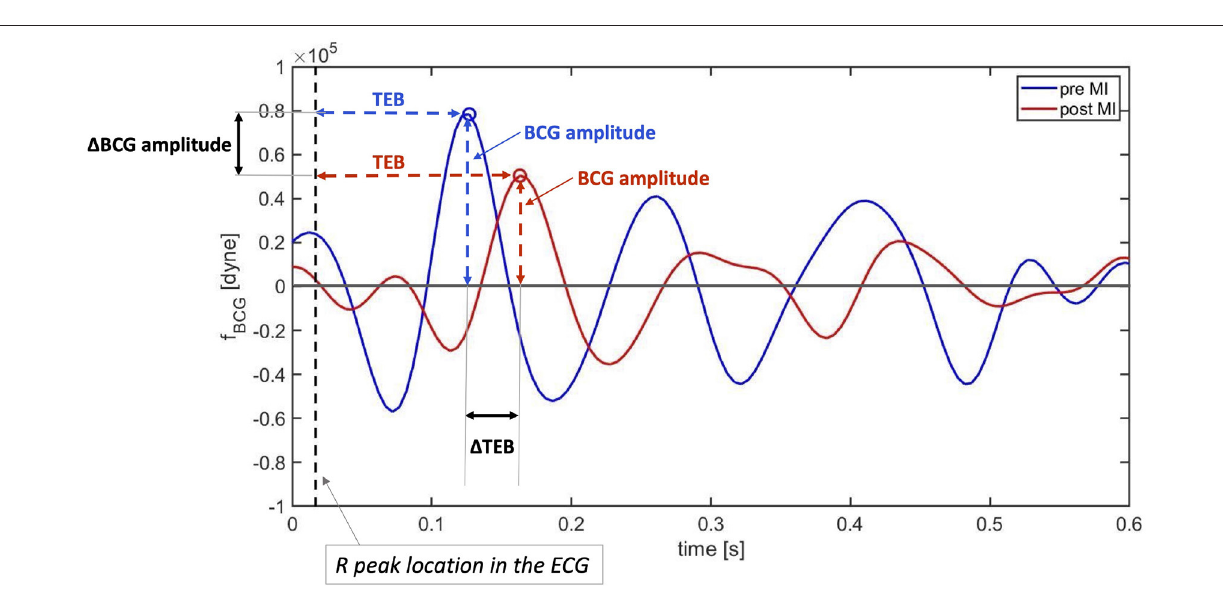
direction corresponds to the z -axis, as shown in Figure 4 . Next, a bandpass filter (see Section 2.4) is applied to the floor-to-ceiling acceleration and a multiplicative factor of − 1 is introduced in order to account for the action-reaction principle. Finally, the signal is multiplied by the swine mass (30 Kg for the animal under consideration) in order to obtain the experimental BCG waveform f BCG in the units of dyne. Pre-MI, the ECG signal appears to be very regular, with strong R peaks marked with vertical black dashed lines in Figure 8